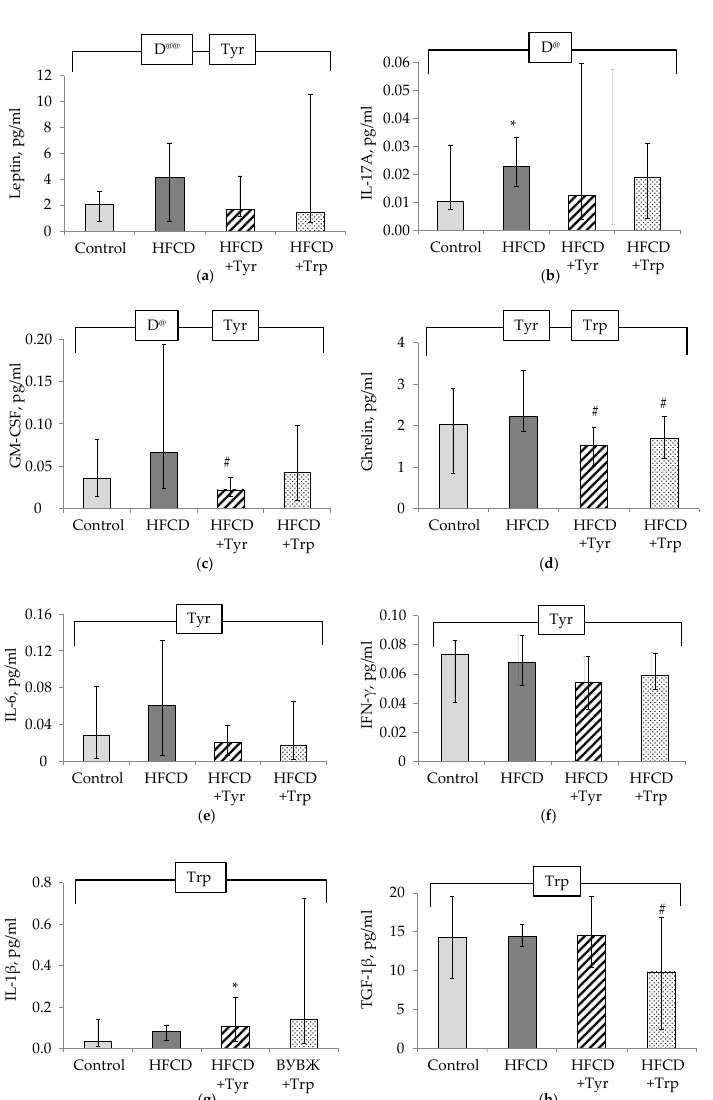
Figure 6. Blood plasma levels of cytokines and adipokines in the rats, median ± intervals of change. Leptin ( a ), IL-17A ( b ), GM-CSF ( c ), ghrelin ( d ), IL-6 ( e ), INF- γ ( f ), IL-1 β ( g ), TGF-1 β ( h ). * the difference with the control group is significant; # the difference with the group receiving HFCD is significant, p < 0.05, Mann-Whitney test. The bracket above the bars denotes significant dependence on the factors: “diet” (D), “tyrosine” (Tyr), “tryptophan” (Trp), p < 0.05, 3-way ANOVA. Indices @ excluding rats receiving Trp, @@ excluding rats receiving Tyr. The number of animals in the groups was 8.